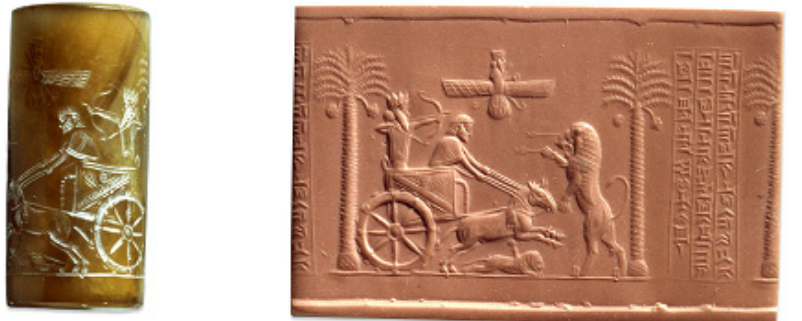
Figure 5. The Great King Darius hunting lions (BM inv. no. 89132; reg. no. 1835,0630.1); cylinder seal, chalcedony (with modern impression); found in Thebes (?), Egypt; Achaemenid, ca. 6th–5th cent. BCE [image courtesy of the Trustees of the British Museum, London].